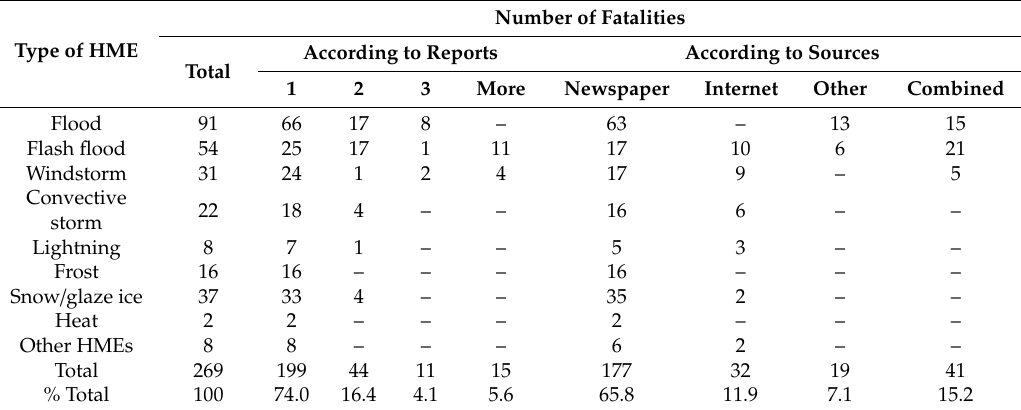
Table 1. Numbers of fatalities related to individual hydrological and meteorological events (HMEs) in the Czech Republic during the 1981–2018 period, categorised by numbers of fatality reports and the type of documentary sources from which fatalities were